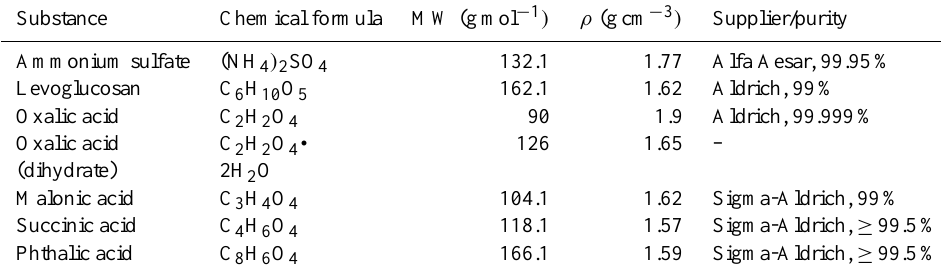
Table 1. Chemical properties of investigated organic species.